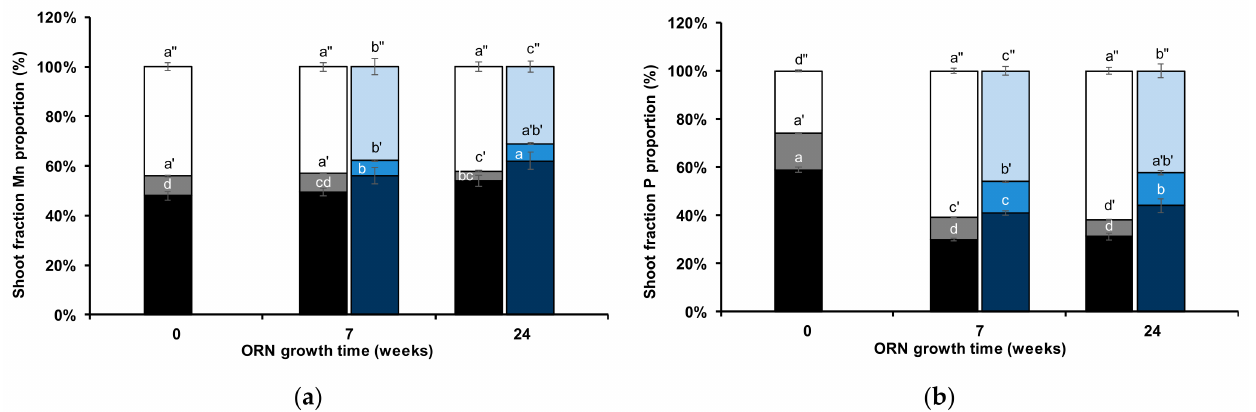
Figure 3. Subcellular distribution (%, average and standard error) of manganese ( a ) and phosphorous ( b ) (cell wall fraction, black columns (disturbed) and dark blue columns (undisturbed); organelle fraction, grey columns (disturbed) and blue columns (undisturbed) and vacuole contents fraction, white columns (disturbed) and light blue columns (undisturbed)) in shoots of wheat grown in soil with previously grown Ornithopus compressus (ORN), after 0, 7 or 24 weeks. Different letters indicate statistically significant differences ( p < 0.05) based on Tukey’s